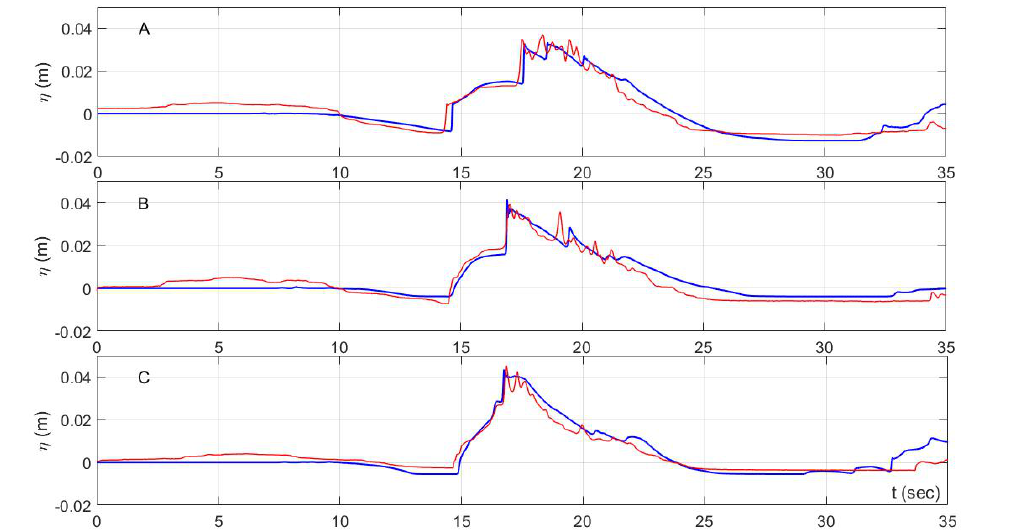
Figure 14. Numerical result (blue) and experimental data (red) at location A (top), B (middle) dan C